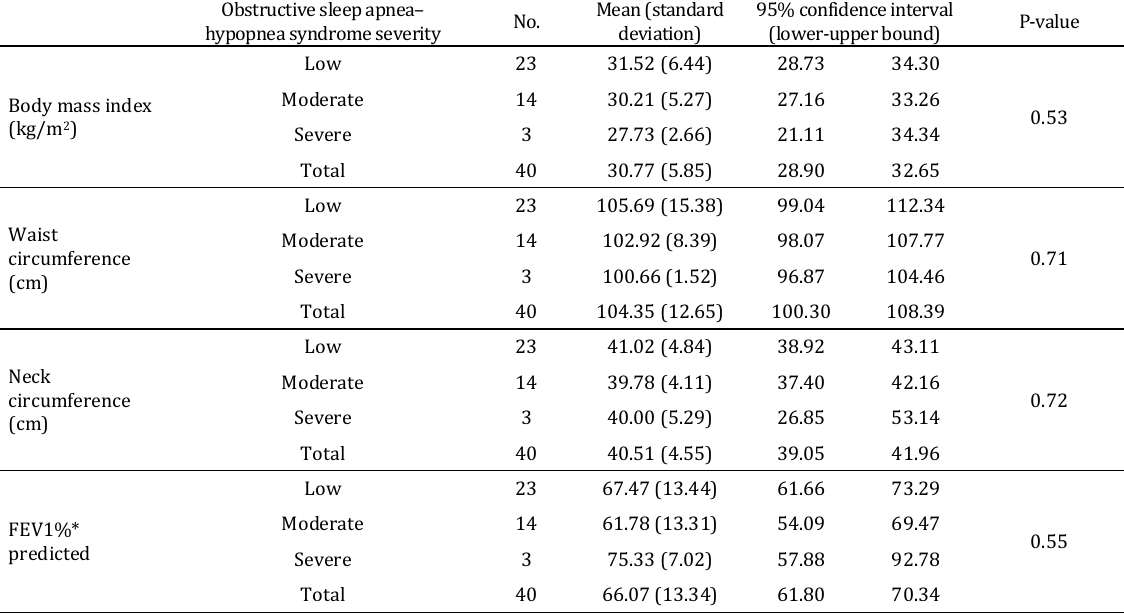
Table 1. Correlation between severity of obstructive sleep apnea–hypopnea syndrome (as determined by apnea–hypopnea index in overlap patients) and body mass index, anthropometric variables, and apnea–hypopnea